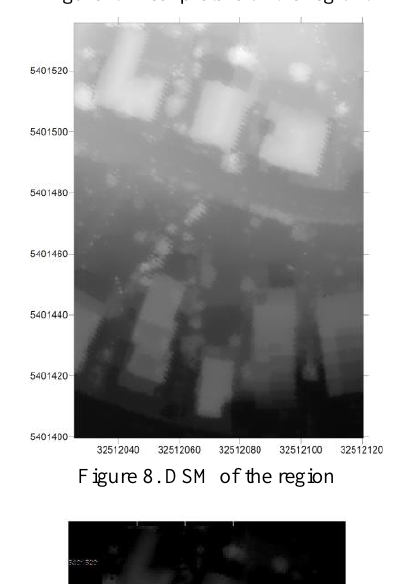
Figure7. Areal picture of the region.